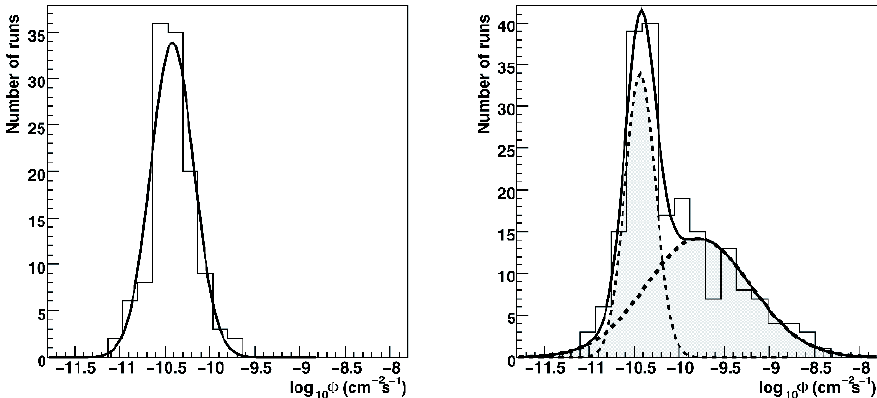
Figure 4. Distributions of the logarithms of integral VHE fluxes above 200 GeV for PKS 2155-304. Left: From 2005–2007, without the strong flare period in July 2006. Right: All data, from 2005–2007; the solid line represents the fit by the sum of two Gaussians. The findings provide evidence that the source switches from a quiescent VHE state with rather minimal activity to a flaring state, with the flux distribution in each state following a lognormal distribution (see also [39]). From [36].